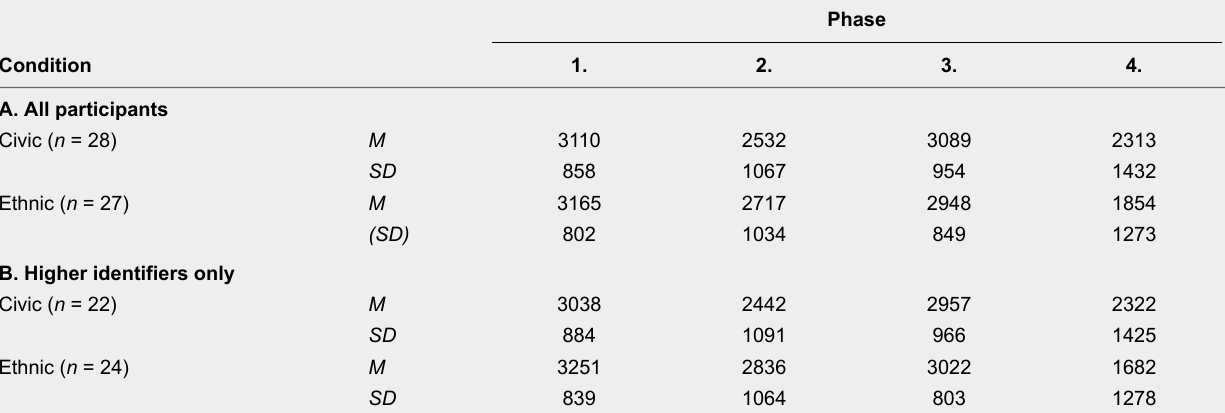
Study 3: Audience Response During the Last 20 Seconds of Each